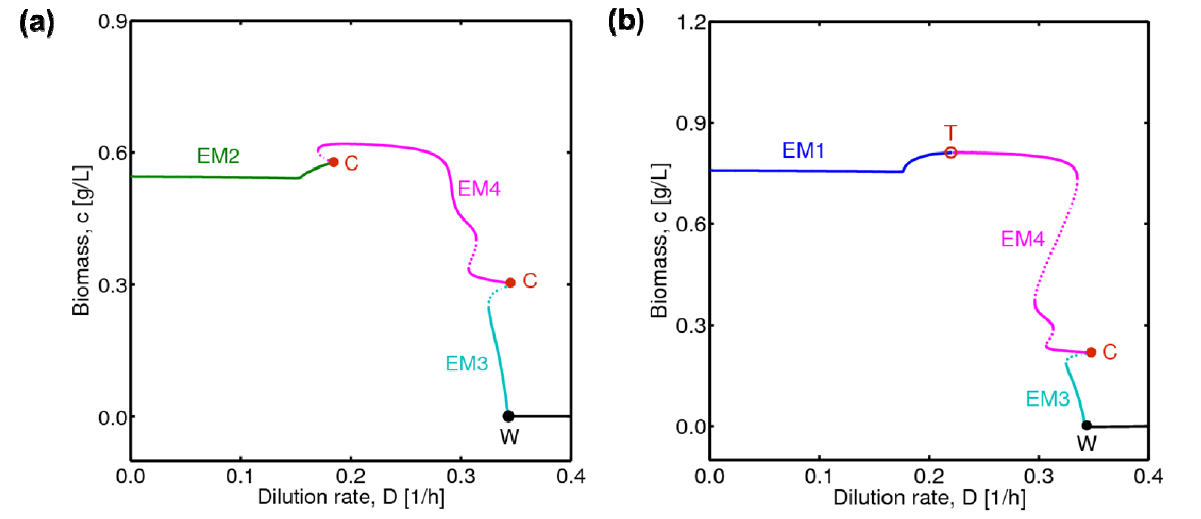
Figure 2. Overall hysteresis curve generated by integrating individual pieces of feasible branches: ( a ) γ = 0.2, ( b ) γ =